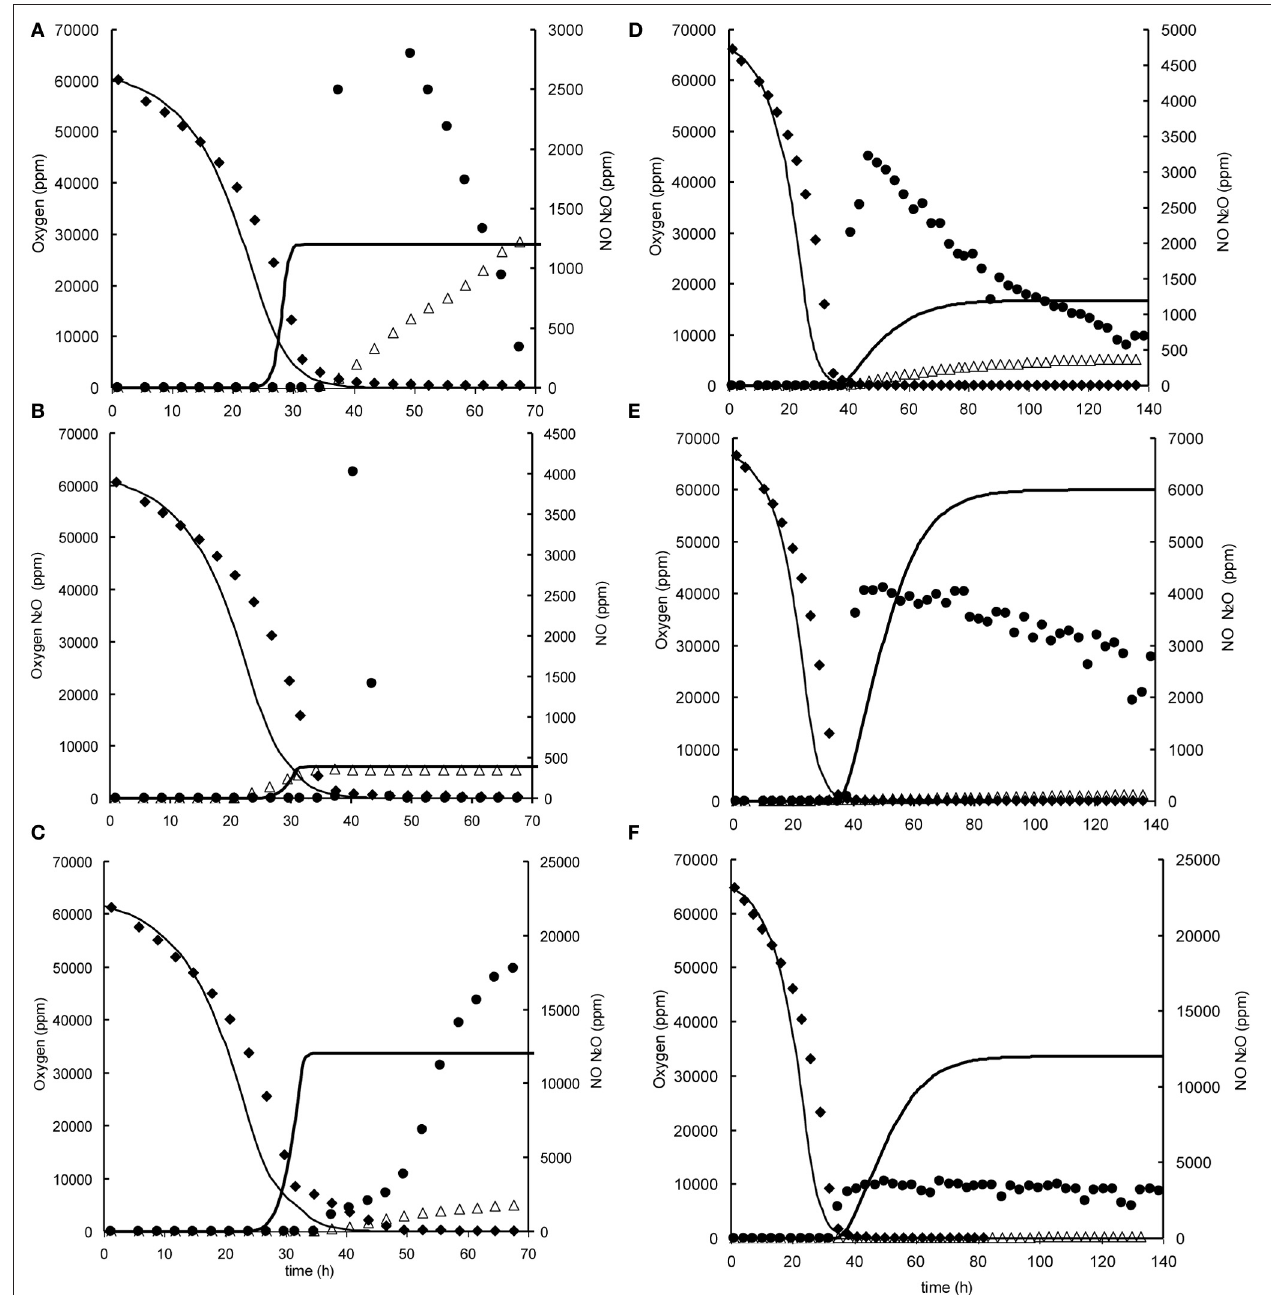
FIGURE A2 | Modeled(lines)andmeasured(points) gasphase concentrationsofoxygen( (cid:4) ),NO( • ), andN 2 O( (cid:2) )duringexperiments at7%initialoxygenconcentrationinheadspacewithnitriteandnitrate